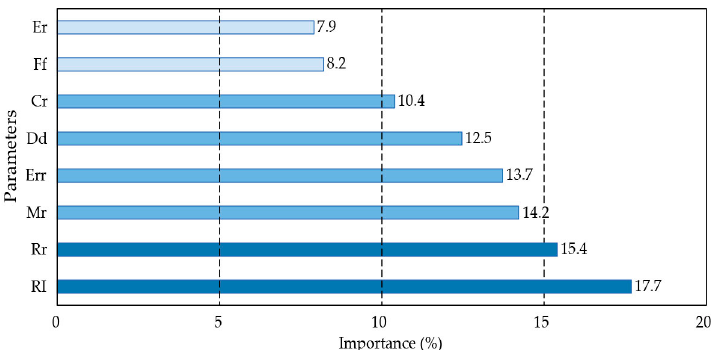
Figure 7. Relative importance values of the parameters for the DFP types.